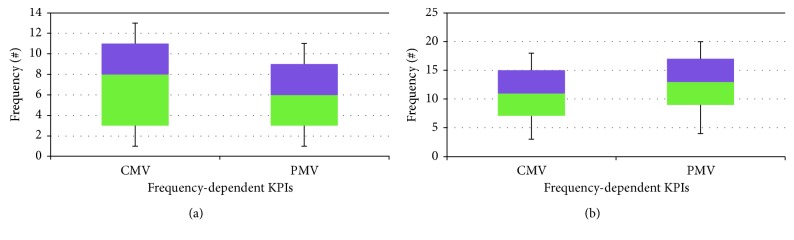
The box and whisker plot of two frequency-dependent KPIs: (a) before OpenMEDIS and (b) after OpenMEDIS.